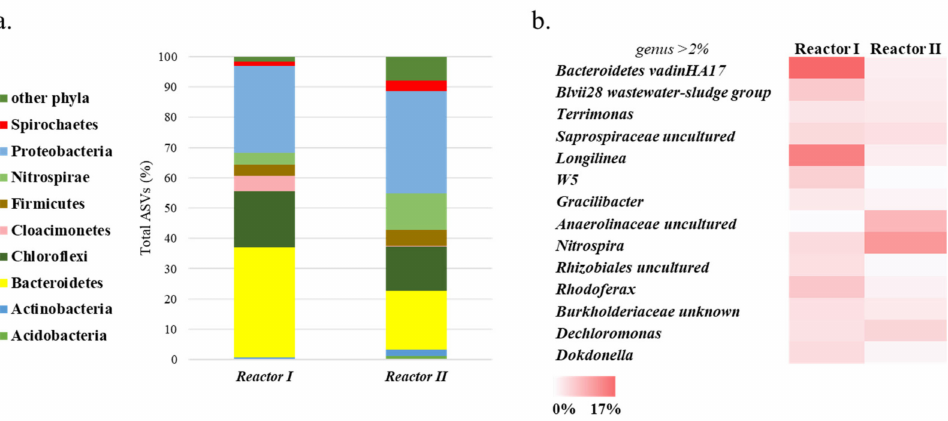
Figure 3. Bacterial microbiome estimated by high throughput 16 S rRNA gene sequencing in R-I and R-II sampled at the end of the operations at taxonomical phylum ( a ) and genera ( b ) levels. Only taxonomy groups having ≥ 2% of abundance in at least one sample are shown.